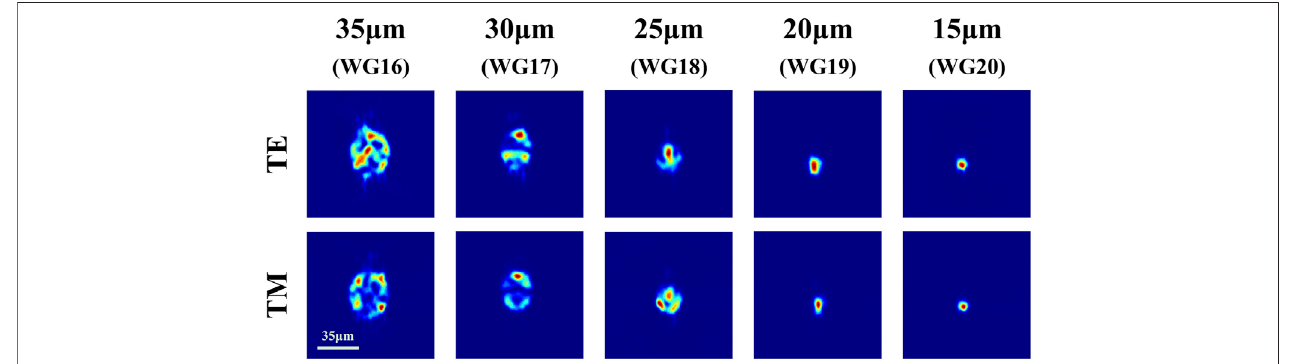
FIGURE 2 | Model pro fi les of the cladding waveguides WG16-WG20 at 633 nm under TE and TM polarization.